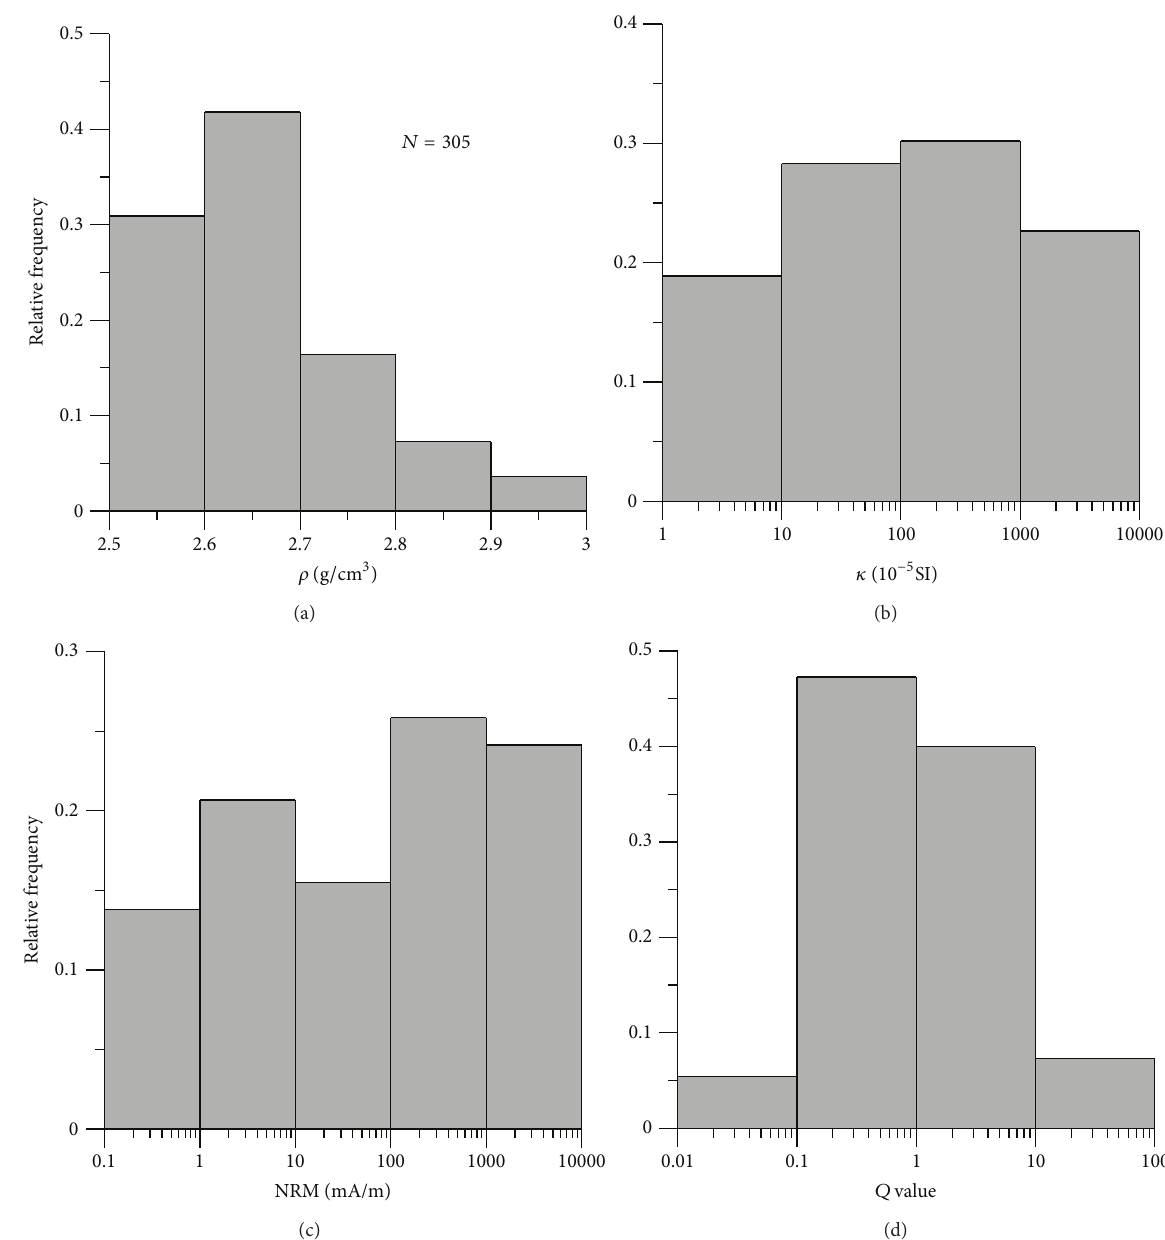
Figure 4: Histogram for (a) 𝜌 , (b) 𝜅 , (c) NRM, and (d) 𝑄 of igneous rock